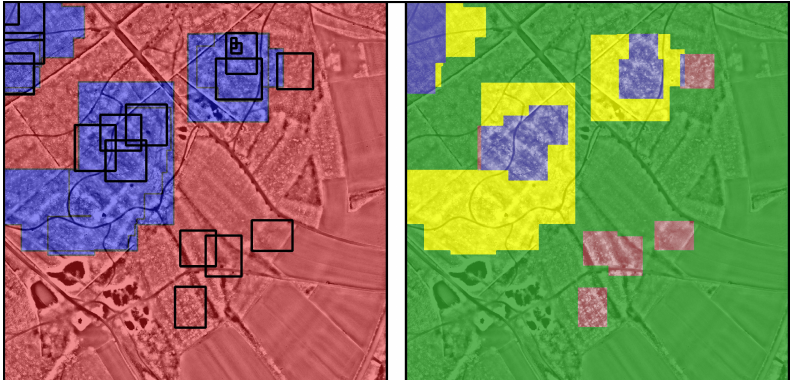
Figure 4. The semi-automatic GIS-based measure [6] for the archaeological evaluation of landscape patterns: ( Left ) the detection polygons (black) on the spatial layer with Celtic fields polygons in blue ( (cid:110) ) and the ’negative’ polygon in red ( (cid:110) ); ( Right ) results of the processing with detected areas of Celtic field (TP) in blue ( (cid:110) ), missed areas of Celtic field (FN) in yellow ( (cid:110) ), wrong detections (FP) in red ( (cid:110) ) and remaining area of ’negative’ area (TN) in green ( (cid:110)